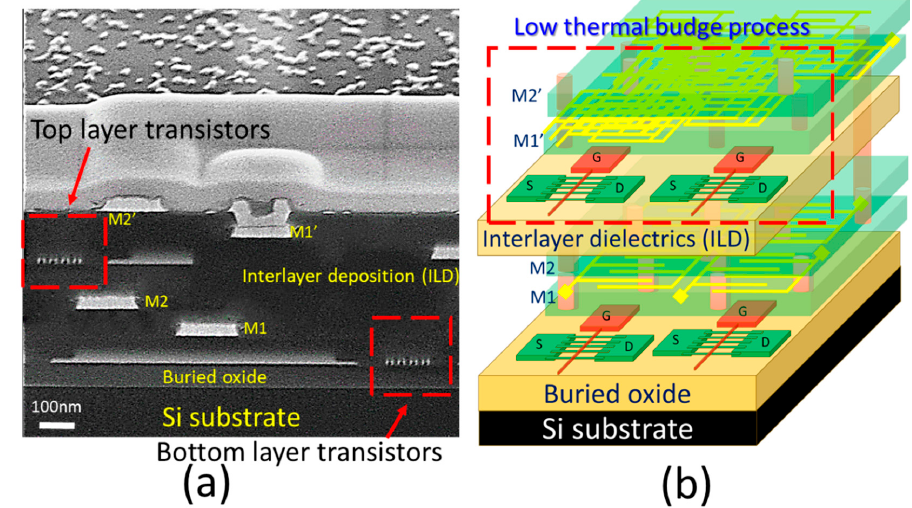
Figure 2. ( a ) SEM image of a 3D sequential integration with two stacking tiers and each tier has a two-layer W interconnect (M1-M2). ( b ) Schematic illusion of a monolith three-dimensional integrated circuit (3DIC) using single-grain GAA Si NW FETs.